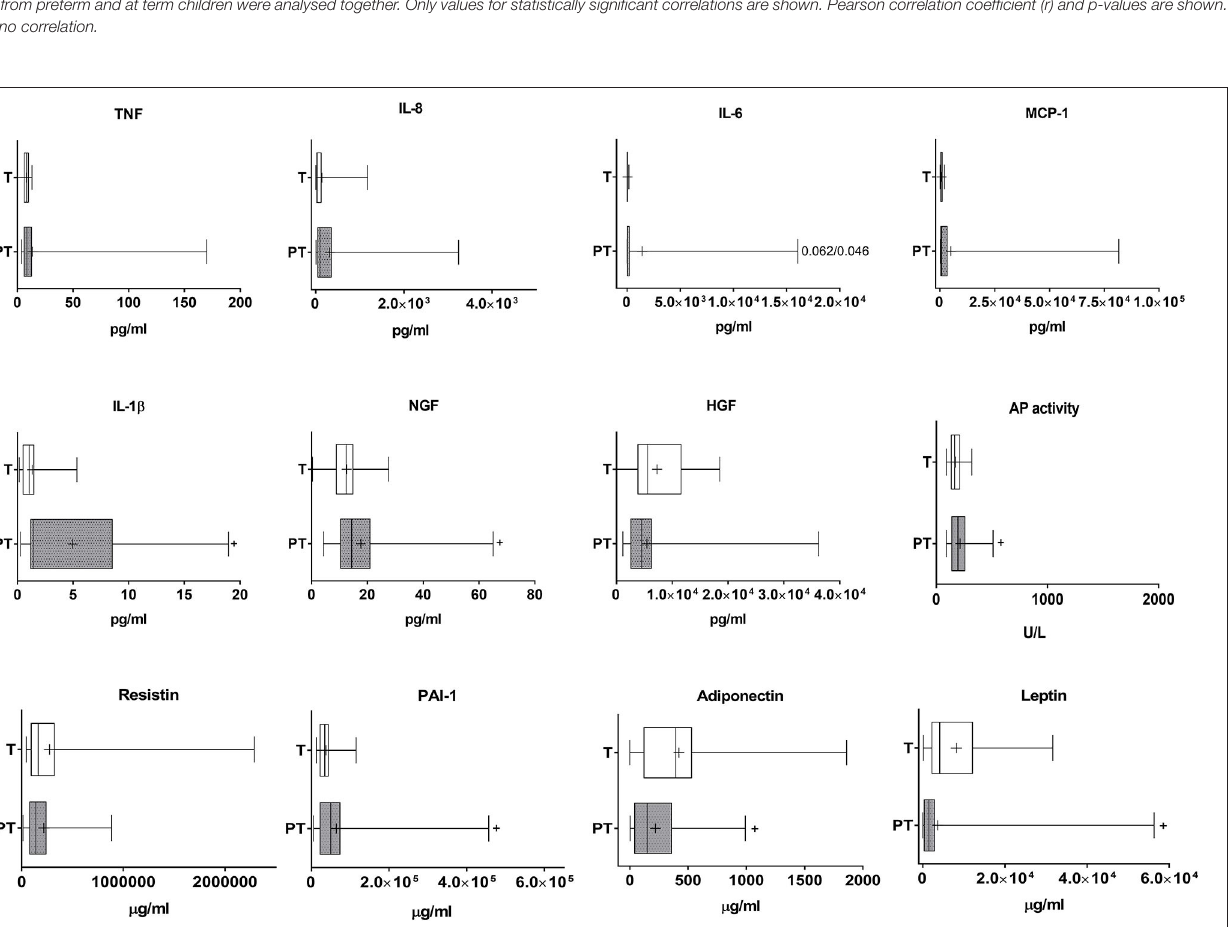
Frontiers in Pediatrics |